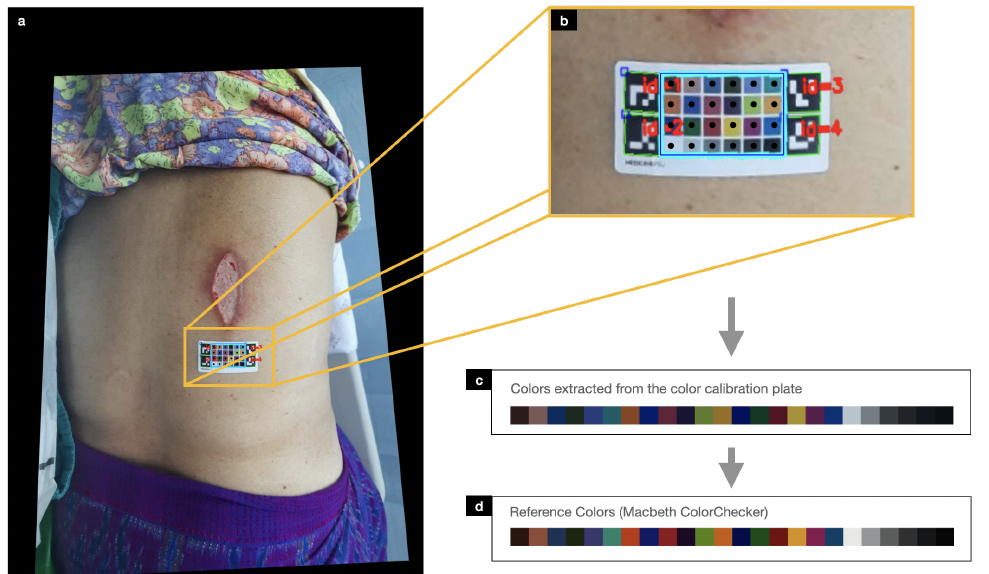
Figure 5. Color calibration process consists of ( a , b ) detecting the color and measurement chart using the ArUcO markers, ( c ) extracting all 24 color plates in the color and measurement chart, and ( d ) calibrating them against their reference